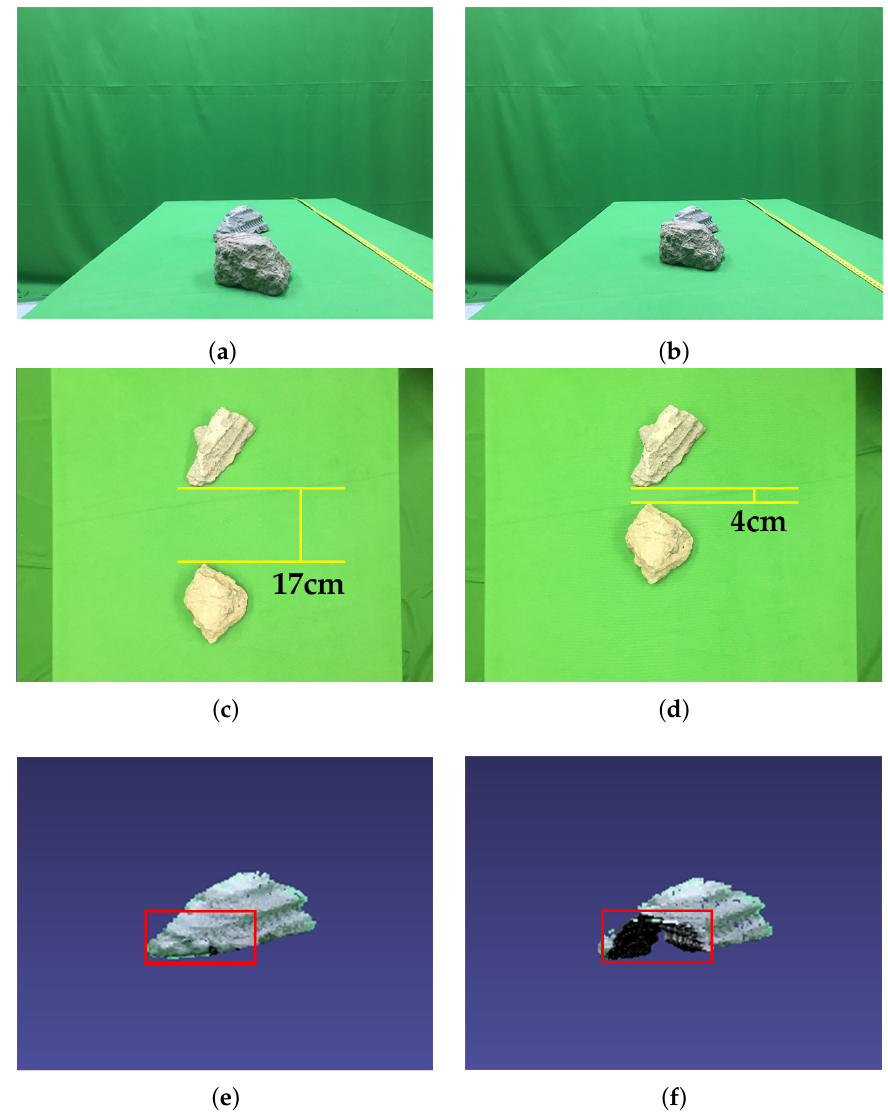
Figure A6. ( a ) Reference view of the rock scene, and the scenario of too-close and serious occlusion. ( b ) Reference view of the rock scene, and the scenario of general occlusion. ( c , d ) Top view of the rock scene. ( e ) Reconstruction result under serious occlusion condition. ( f ) Reconstruction result under general occlusion